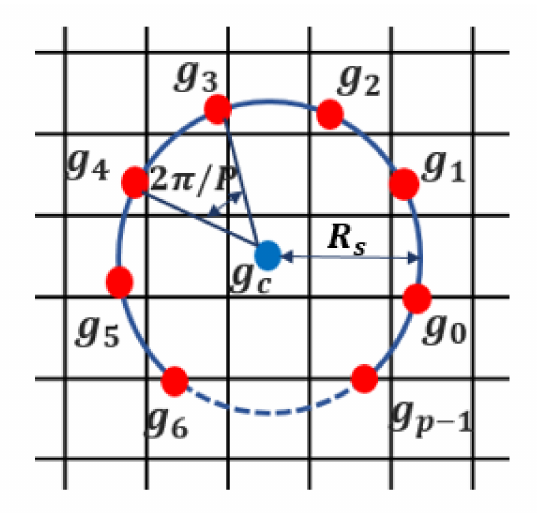
Figure 2. P -nearest neighbors evenly spaced from the center pixel and circle of radius R s